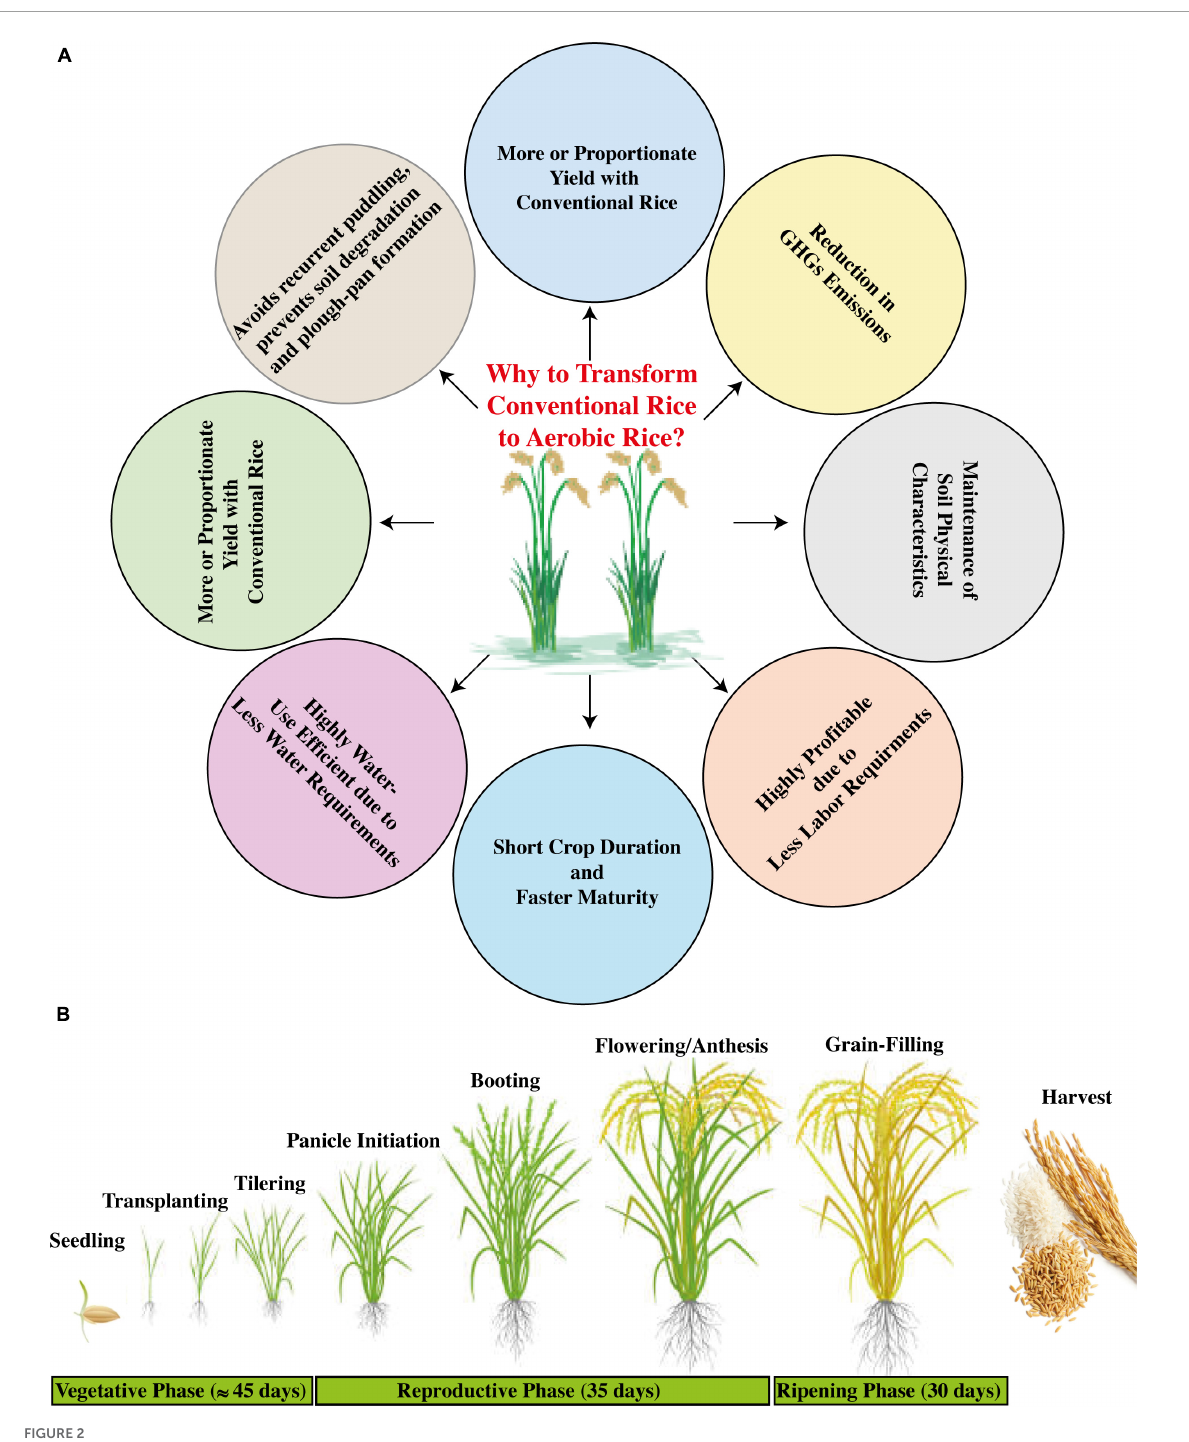
FIGURE2 Transformation of conventional rice to aerobic rice system (Source: Joshi et al., 2018). (A) Benefits of aerobic rice system (Source: Silwal et al., 2020), and (B) elaboration of its growth phases (Source: Shah et al., 2014).